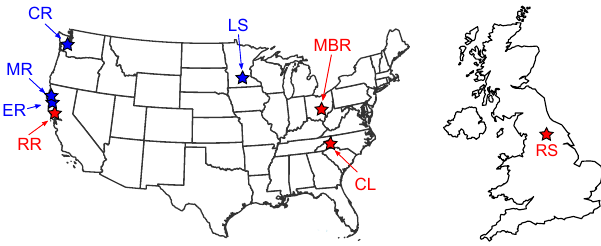
Figure 1. Maps of the US and UK showing the location of the eight field sites in the study. Red stars represent floodplain sites; blue stars represent terrace sites. RR: Russian River, CA; ER: South Fork Eel River, CA; MR: Mattole River, CA; CR: Clearwater River, WA; LS: Le Sueur River, MN; MBR: Mid Bailey Run, OH; CL: Coweeta Hydrologic Laboratory, NC; RS: River Swale, Yorkshire,